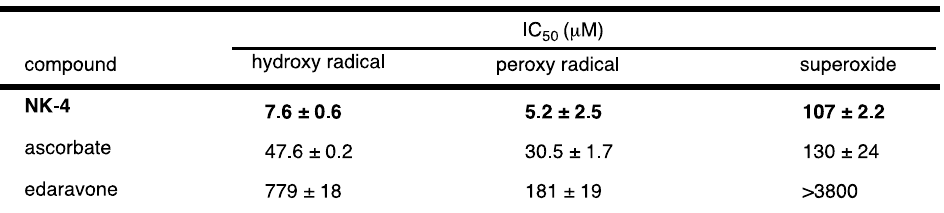
Figure 3. ( A ) Chemical structure of NK-4. ( B ) Structure of NK-4 radical. ( C ) NK-4 peroxy radical generated by O 2 . ( D ) Free radical scavenging